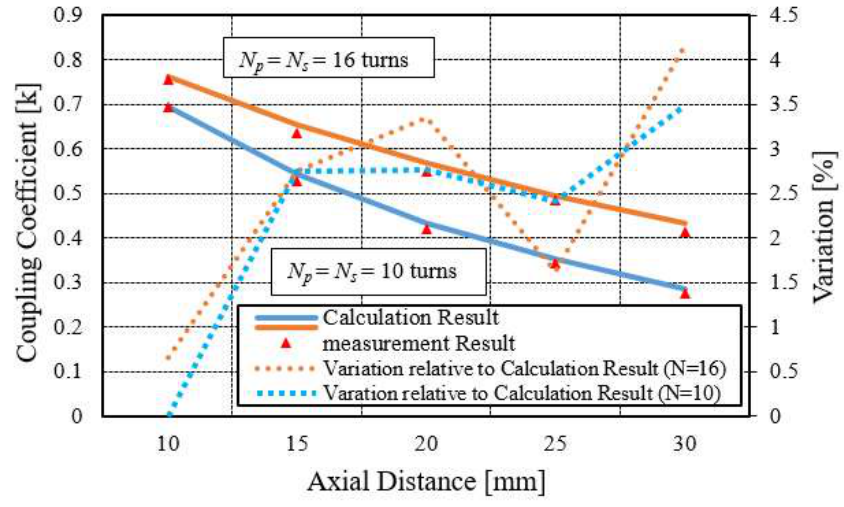
Figure 9. Coupling coefficient as a function of axial distance.